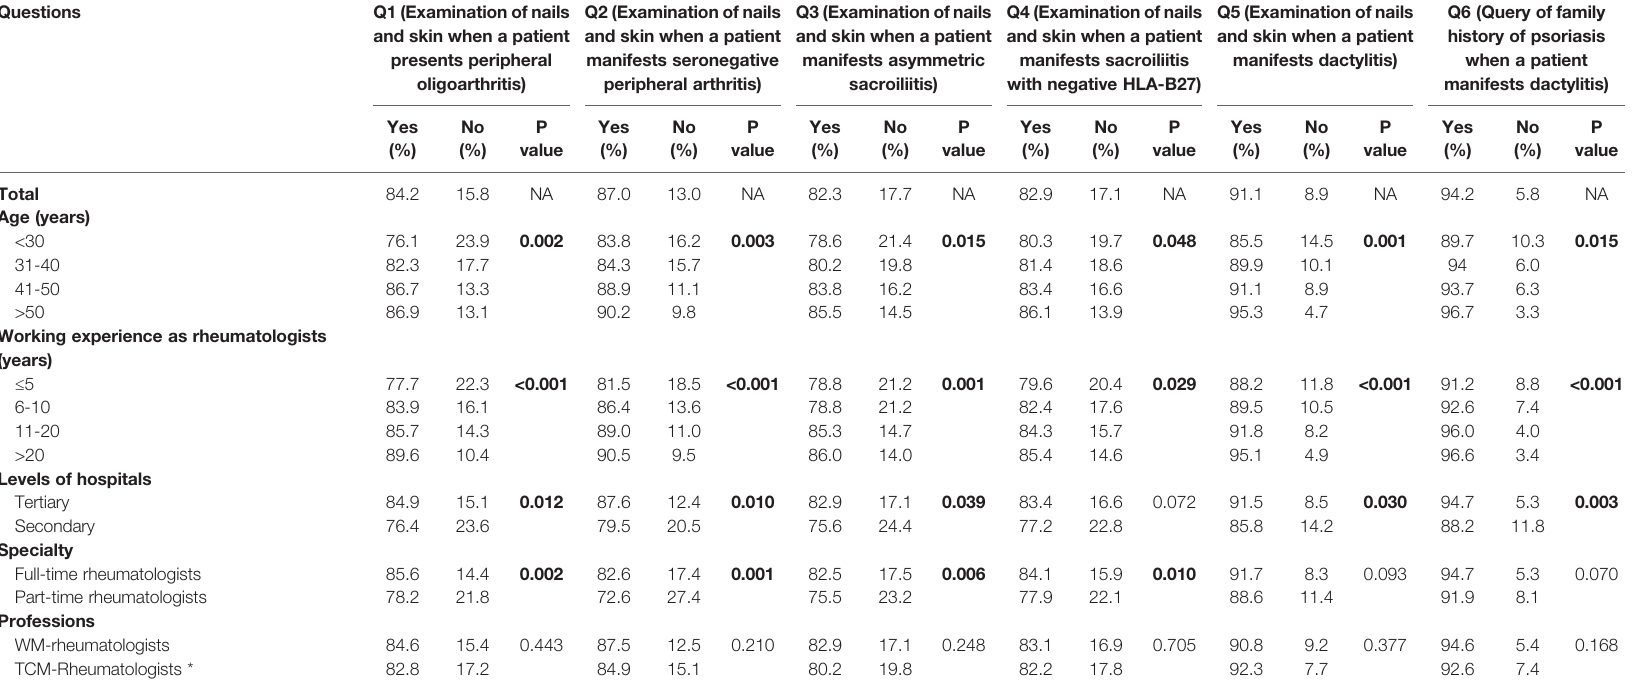
TABLE 2 | Medical practice habits of rheumatologists in responding to key clues of